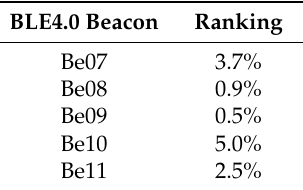
Table 9. Ranking of the transmission power values used by each BLE4.0 beacon for k-NN using mode (with k = 5)